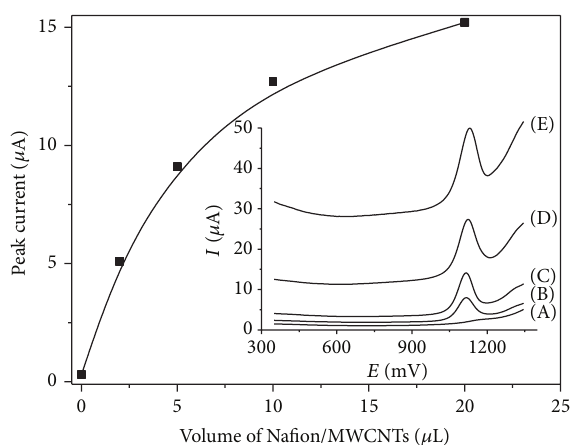
Figure 5: Dependence of the peak current on volume of Nafion/MWCNTs on GC electrode in the range of 0 to 20 𝜇 L for 10 𝜇 M codeine in 0.1M phosphate buffer (pH 3.0) and obtained voltammograms for (A) 0; (B) 2; (C) 5; (D) 10; (E) 20 𝜇 L Nafion/MWCNTs. Instrumental parameters: Δ𝐸 = 50 mV, 𝐸 𝑠 = 5 mV, and 𝑡 𝑤 , 𝑡 𝑠 = 20 ms. Preconcentration potential 300 mV, preconcen- tration time 20 s, and stirring rate 500 rpm.